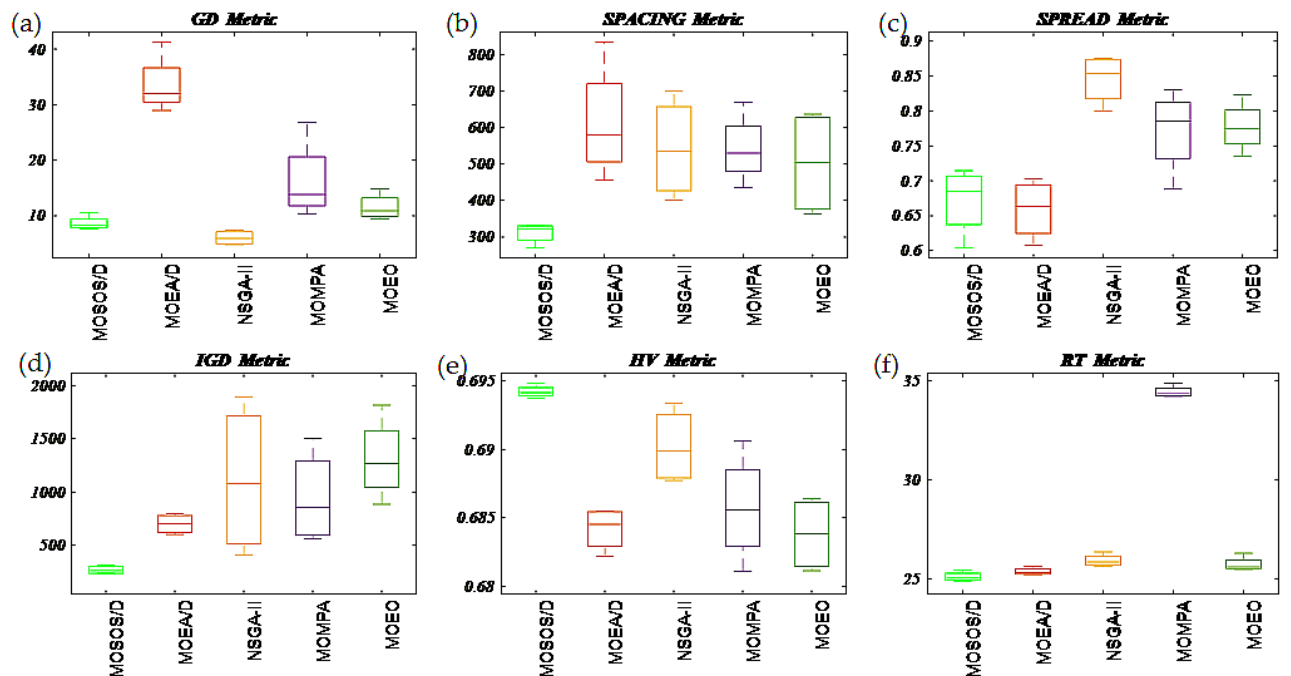
Figure 21. The boxplots of the considered algorithms for the 25-bar truss for various metrics ( a